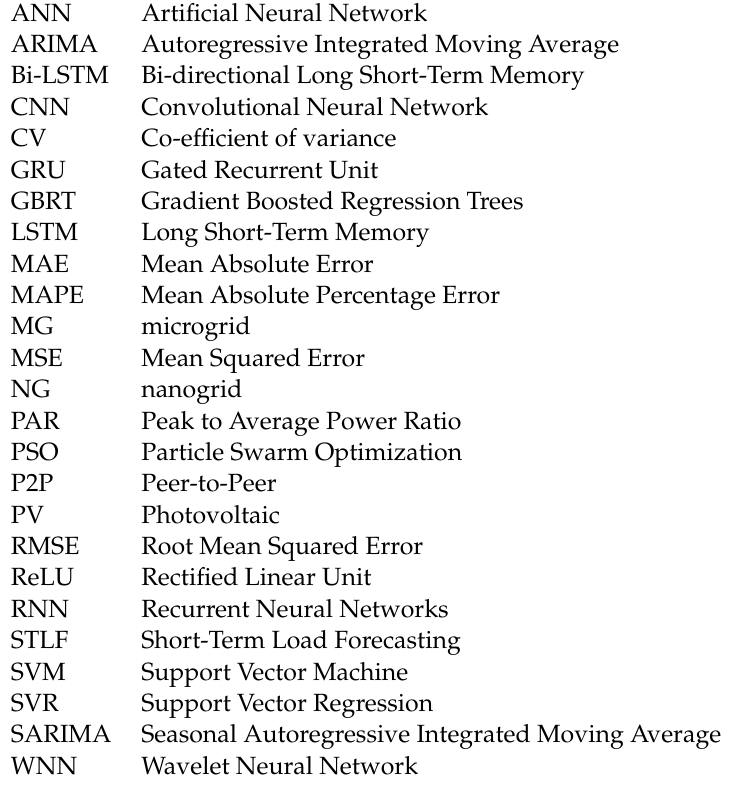
Layer with 200 internal units.